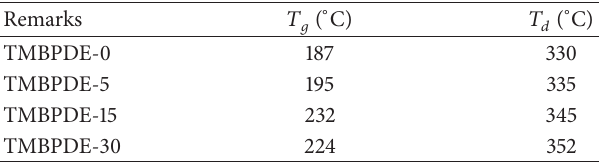
Table 1: Thermodata obtained from DSC ( 𝑇 𝑔 ) and TG ( 𝑇 𝑑